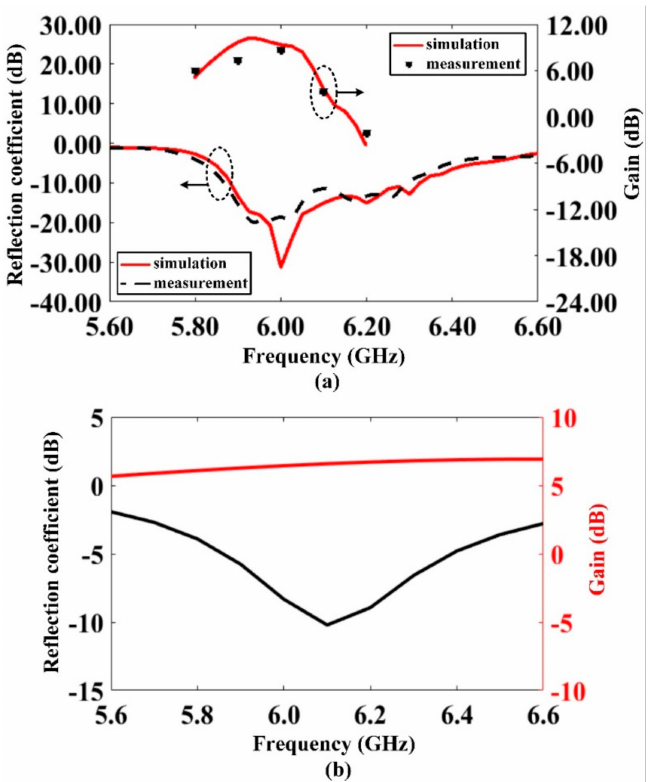
Figure 5. Reflection coefficient and gain frequency response. ( a ) Proposed antenna. ( b ) Reference antenna.